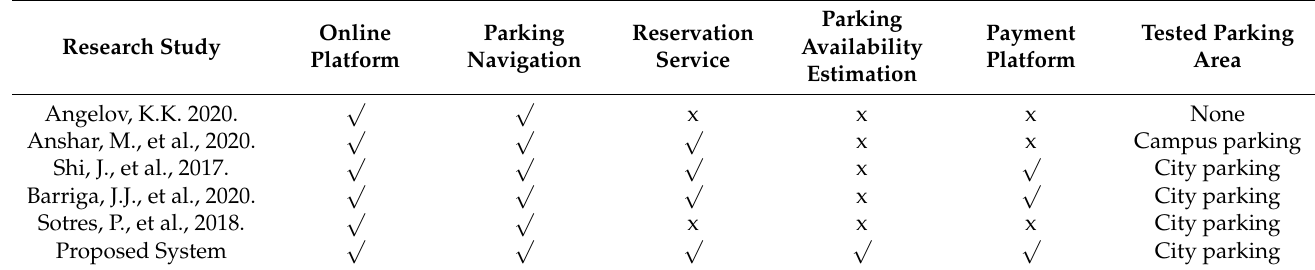
Table 1. A summary of the most relevant parking systems.